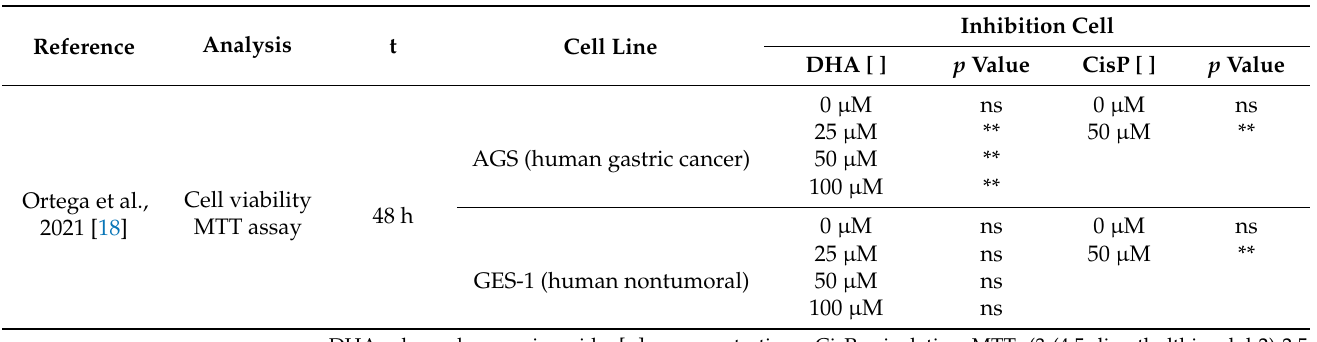
Table 6. Analysis results of the in vitro cytotoxicity tests on stomach nontumor (GES-1) and gastric cancer (AGS) cell